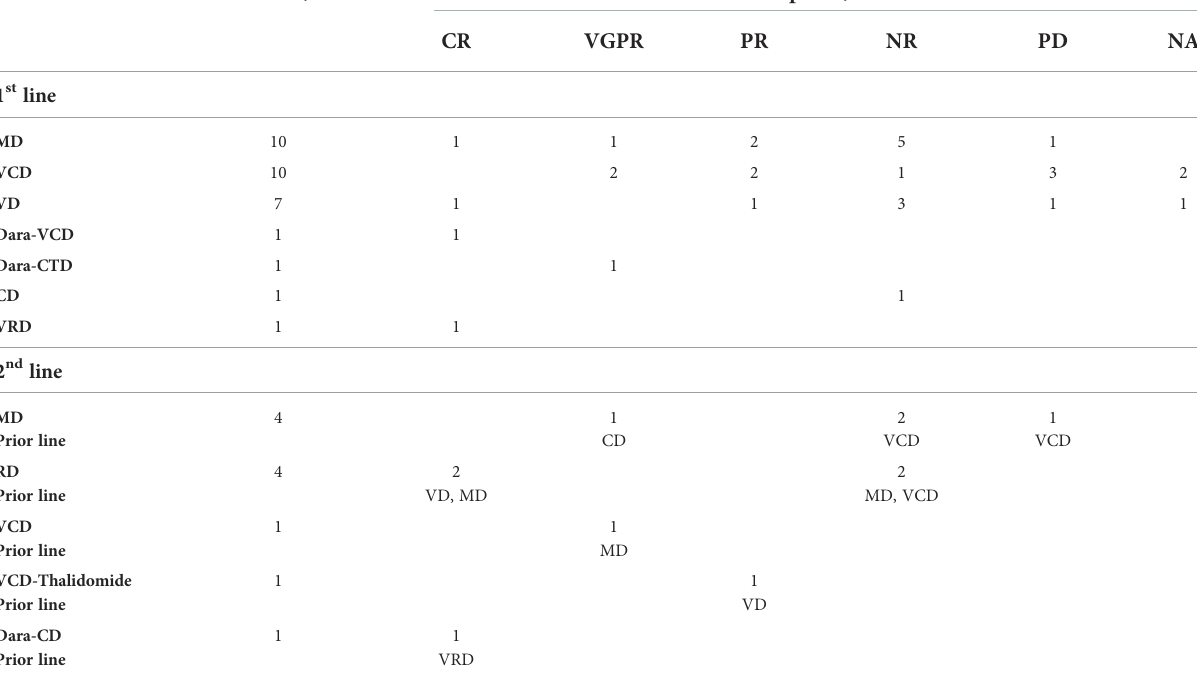
TABLE 3 Treatment and response of patients ’ with AL